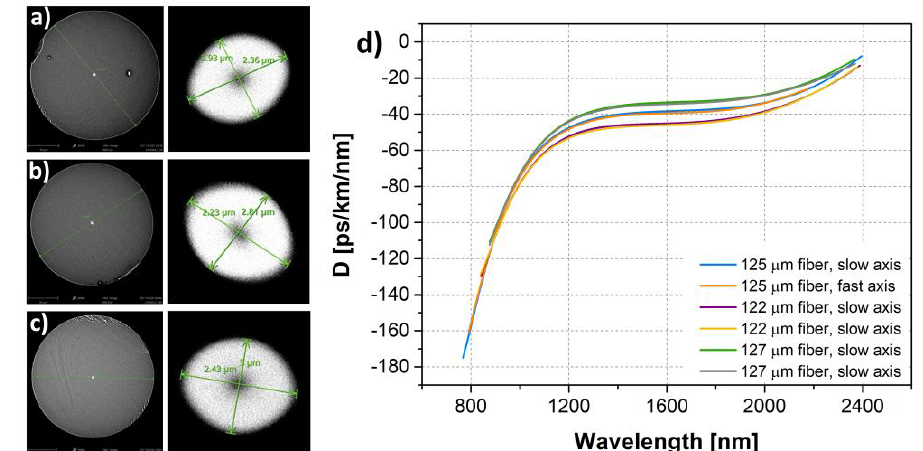
Fig. 1 The cross-sections of the prototype fibers and enlarged core regions obtained with SEM(a-c). The measured dispersion profiles for both polarization axis (d). References (cid:2) 1 (cid:3) A. Hartung, et al “Design of all-normal dispersion microstructured optical fibers for pulse-preserving supercontinuum generation,”